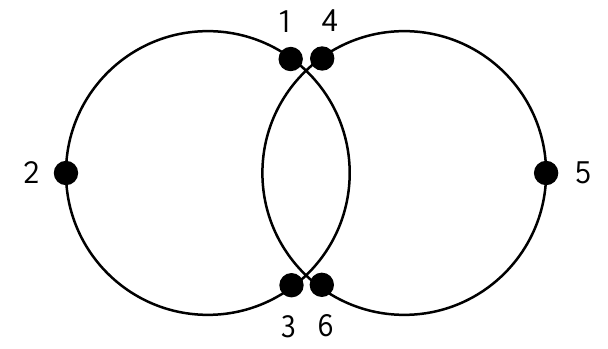
FIG. 1. Position of macroparticles in the synchrotron phase